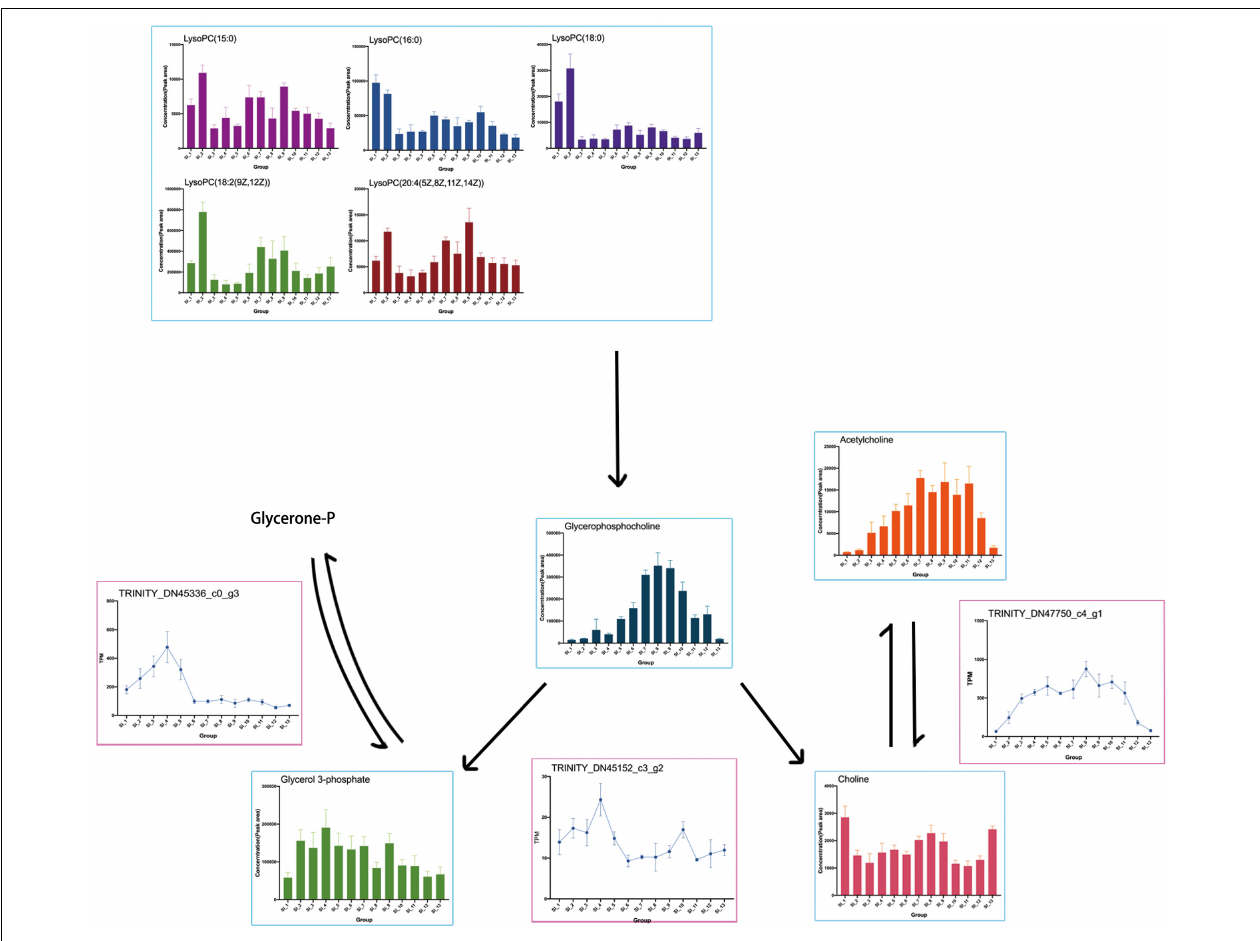
FIGURE 10 | Presumed glycerophospholipid metabolism in the S. insularis larvae during the overwintering. The figure shows the content of metabolites in the pathway and the expression of DEGs that may be related to